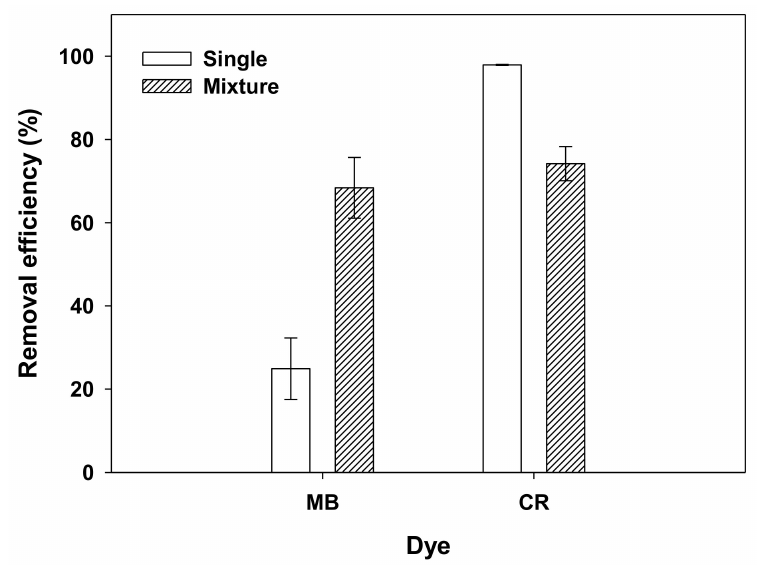
Figure 3. Comparison of adsorption in single dye (methylene blue (MB) or congo red (CR)) and dye mixture (MB and CR) dye solutions onto BC 550 at 30 ◦ C and pH